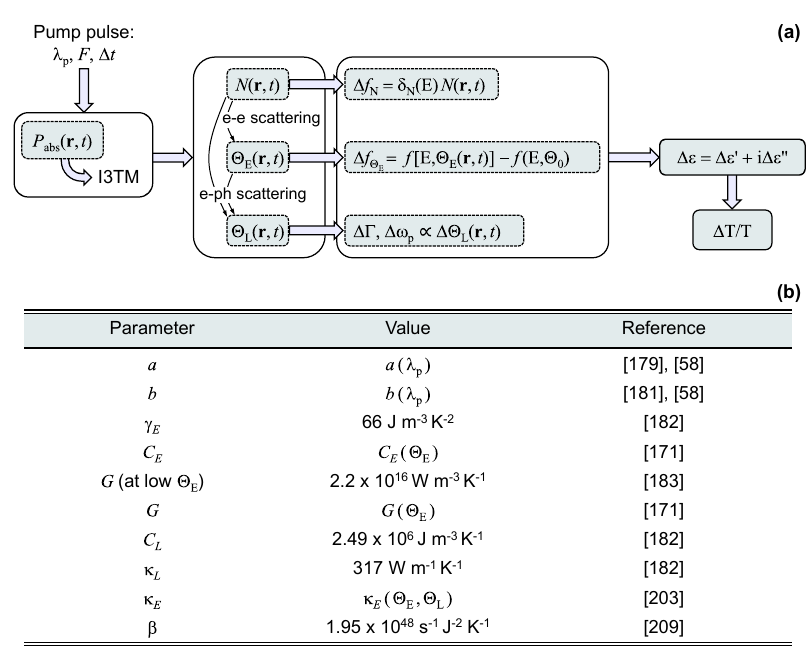
Figure 4: Modelling photoinduced optical nonlinearities driven by hot carrier dynamics. (a) Schematic of the implementation algorithm underlying our modelling approach, which provides the dynamics of typical optical quantities (e.g. the differential transmittance Δ T ∕ T ) retrieved by ultrafast TA spectroscopy, by describing the internal relaxation processes undergone by hot carriers with the I3TM and corresponding nonlinear modulation of the , fluence F and temporal duration Δ t . (b) Table of the typical values and references for metal permittivity starting from the pump pulse wavelength 𝜆 p the most relevant parameters employed in the I3TM when applied to